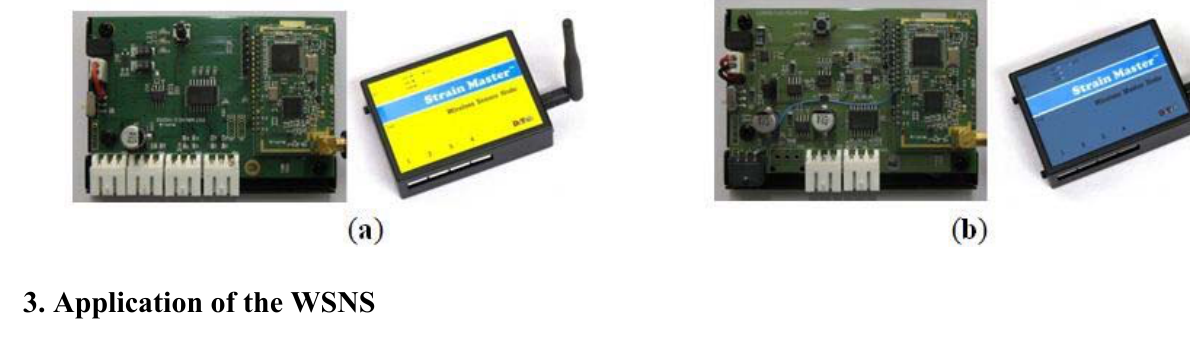
Figure 3. Wireless nodes. ( a ) Sensor node; ( b ) Master